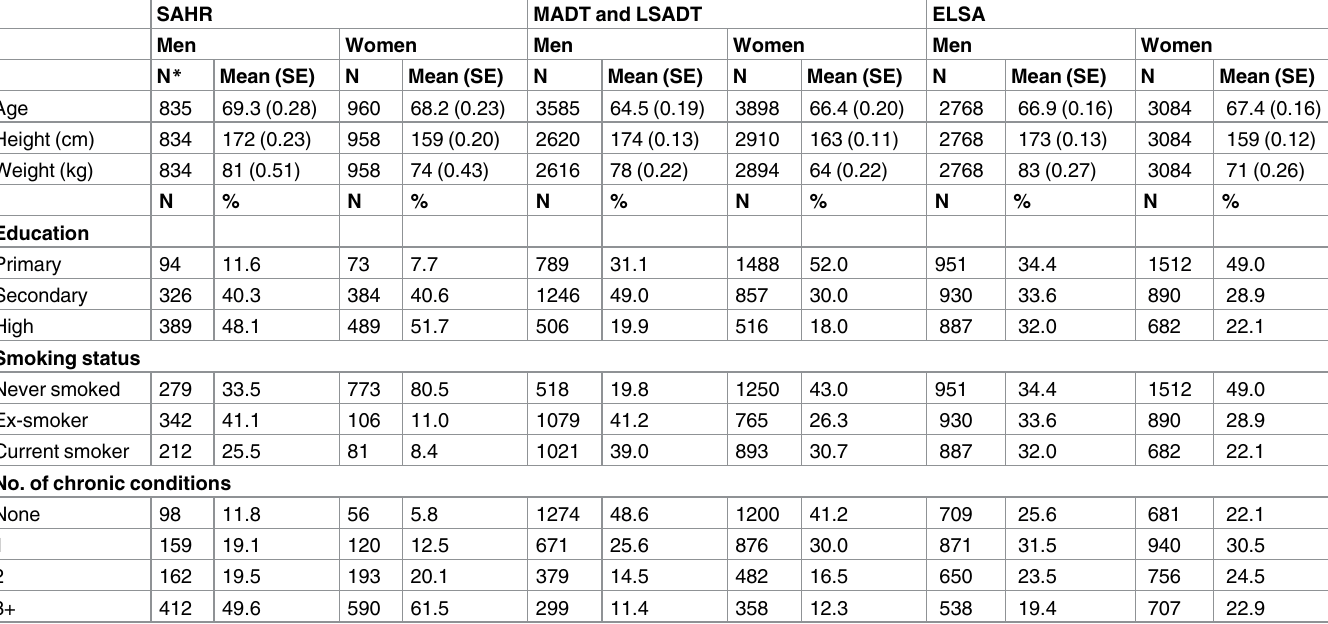
Table 1. Descriptivecharacteristics of the Muscovite, Danish, and English